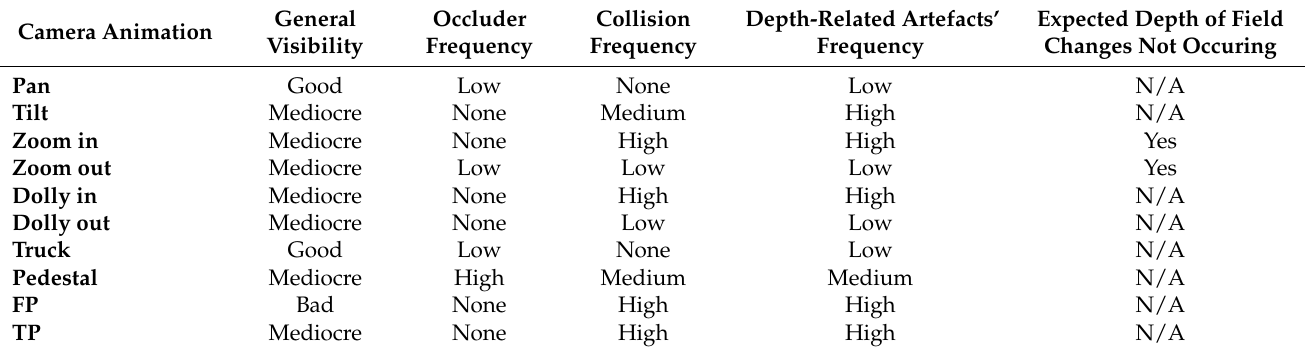
Table 2. Results of camera animations visualized on the light field